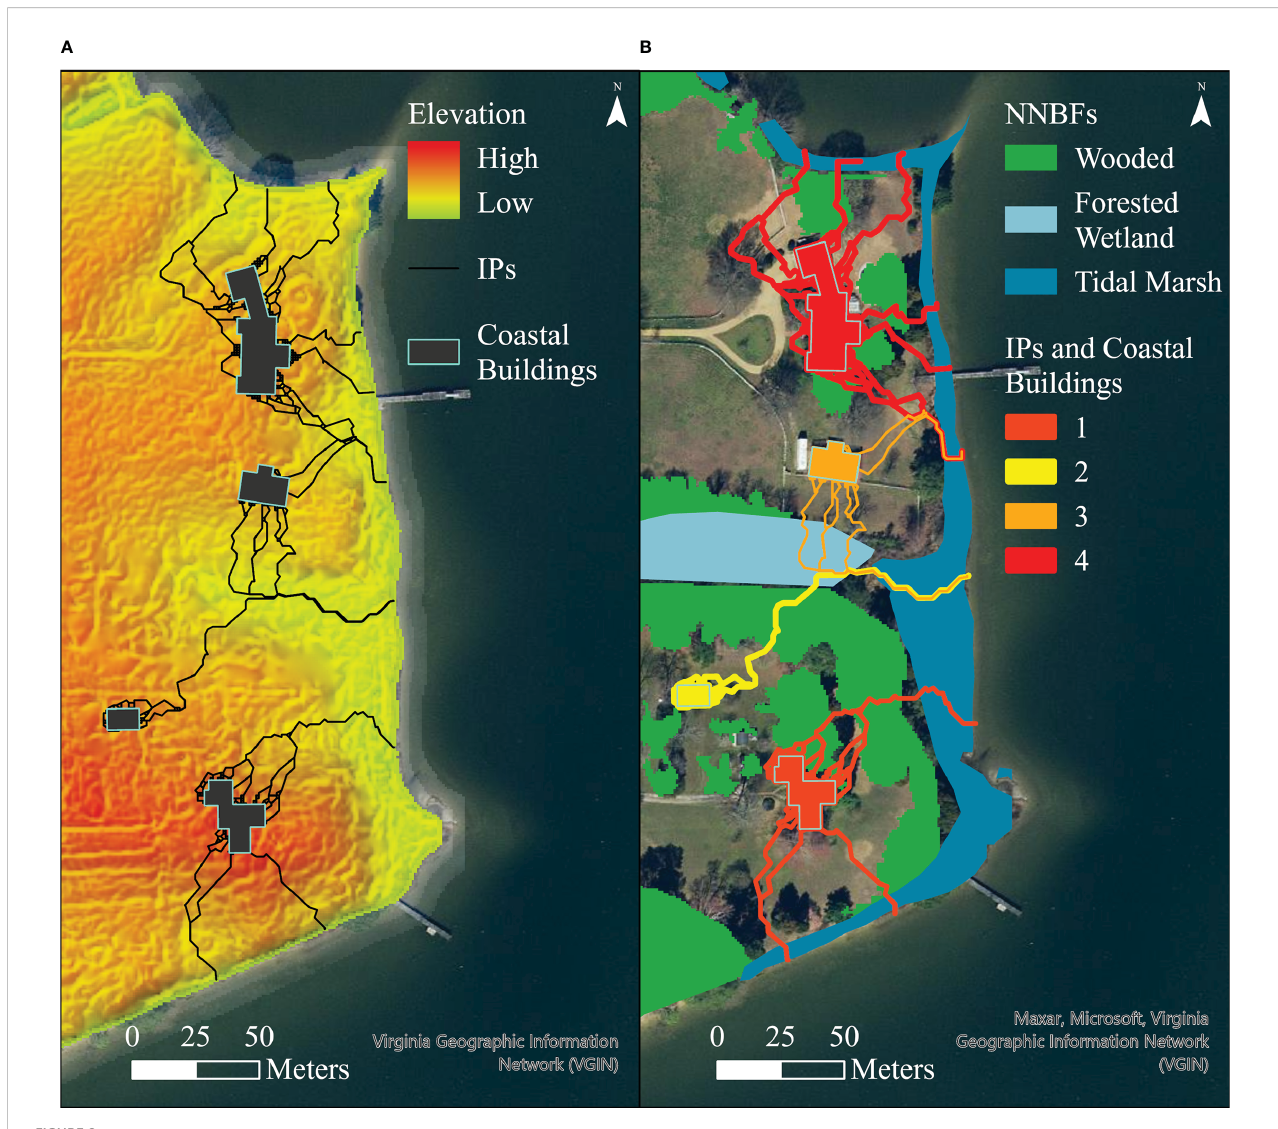
FIGURE 2 Maps depicting Inundation Pathways (IPs) and coastal building footprints for a location in the Middle Peninsula. (A) shows buildings and IPs with the underlying elevation raster, illustrating that IPs follow the lowest overall elevation connections between a building and the shoreline. (B) depicts those same buildings and IPs showing how each IP/building may be complex in shape and that buildings can have overlapping IPs. This fi gure also displays the spatial relationship between IPs and NNBF. (Imagery source: Virginia Geographic Information Network,